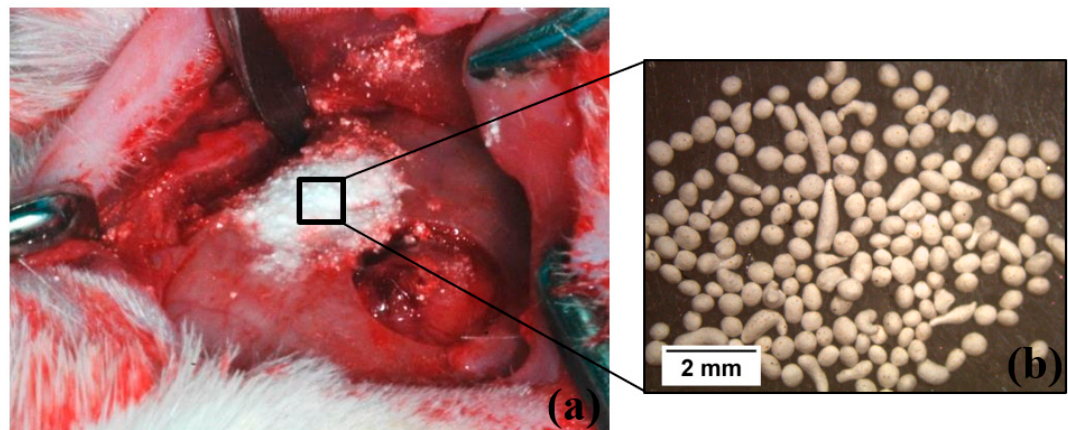
Figure 1. ( a ) Surgical image of the defects created. One defect was empty (negative control group); the other was filled with composite granules shown in ( b ), (experimental group).